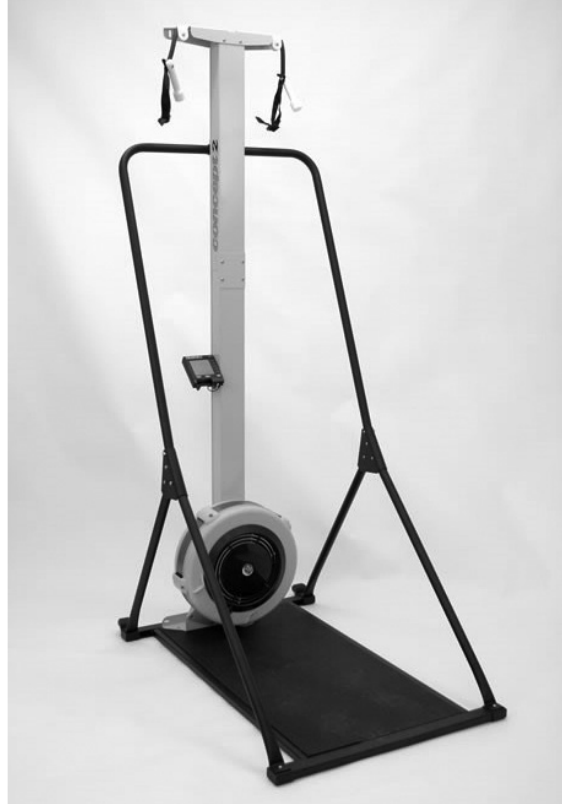
Figure 1. SkiErg “Concept